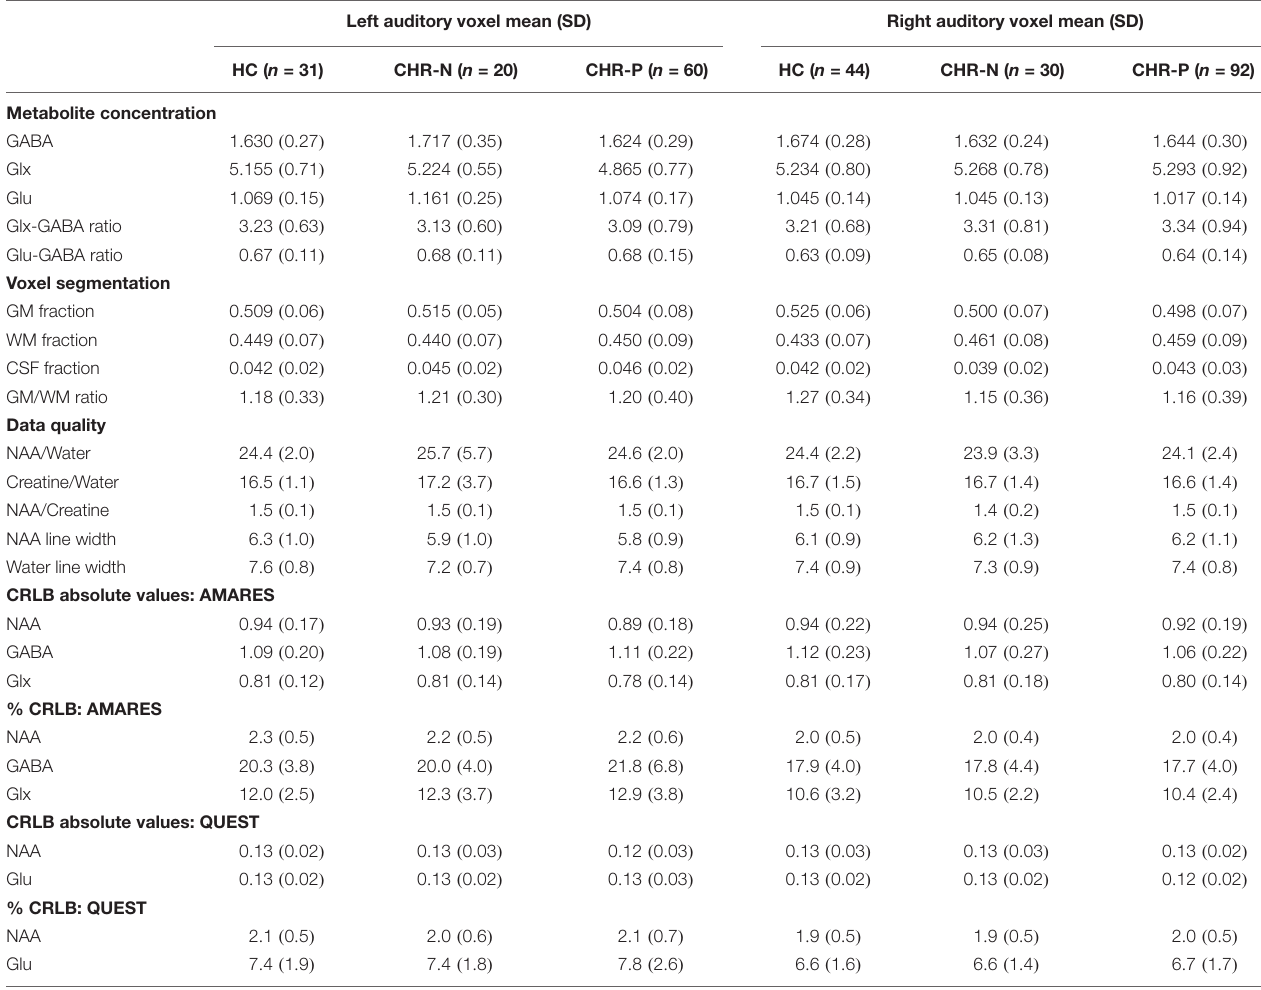
TABLE 1 | Metabolite concentrations, voxel segmentation fractions, and data quality measures. Left auditory voxel mean (SD) Right auditory voxel mean